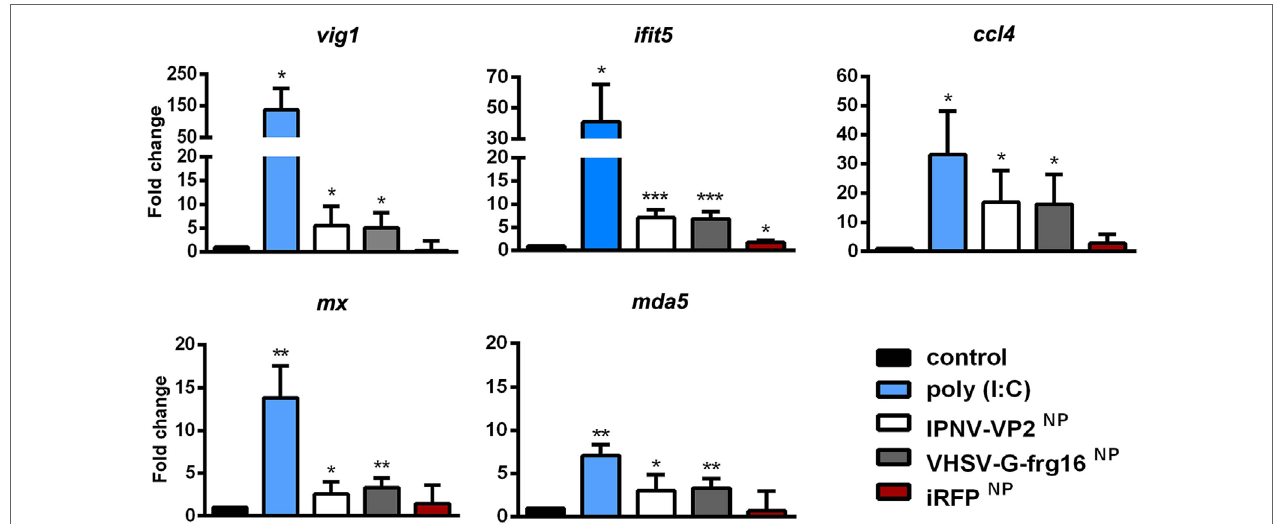
FigUre 4 | Gene expression analysis in RT-HKM stimulated with salmonid viral nanopellets (NPs). Cells were incubated for 15 h as follows: unstimulated control cells (black), poly(I:C) 10 µg/ml as a positive control (blue), IPNV-VP2 NP 10 µg/ml (white), VHSV-G-frg16 NP 10 µg/ml (gray), and iRFP NP 10 µg/ml as an immunogenically irrelevant NP control (red). Samples are from two independent experiments. Data are mean ± SD ( n = 4). Gene expression was determined by quantitative real-time PCR with three technical replicates. Differences between each treatment mean and control were analyzed by unpaired one-sided t -tests with Welch’s correction for unequal variances. Significance levels * p < 0.05; ** p < 0.01; *** p <